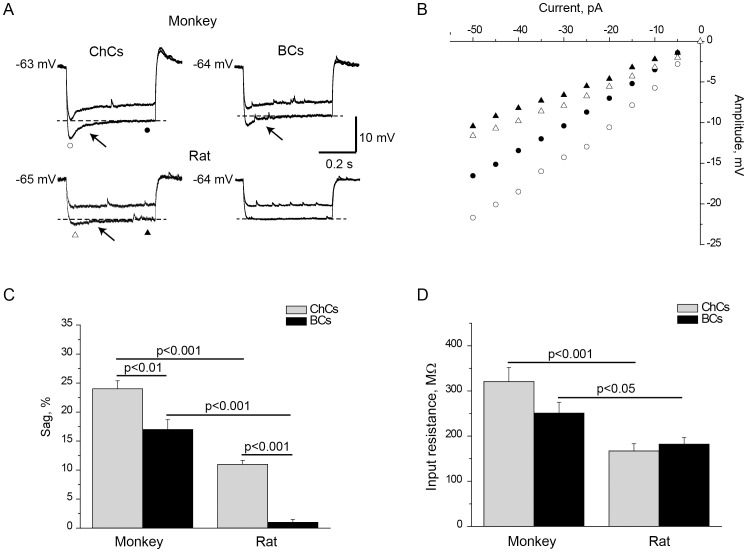
Differences in responses to hyperpolarizing current pulses in ChCs and BCs from monkey and rat.A. Voltage responses to the hyperpolarizing current steps in ChCs and BCs from monkey and rat. Both monkey ChCs and BCs as well as rat ChCs showed time-independent inward rectification (“sag”; arrows). B. Current-voltage plots for traces shown in A. Comparison of average values of sag (C) and Rin (D) in monkey and rat ChCs and BCs. Error bars represent SE.